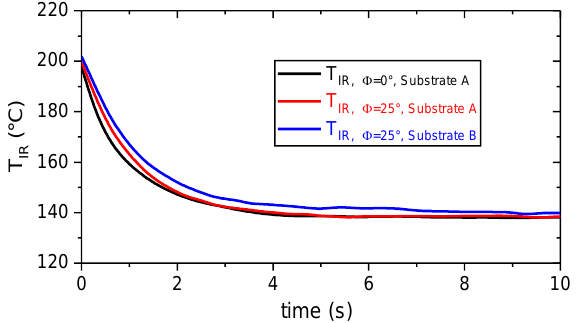
Figure 8. Polymer surface temperature, T IR, as a function of time during the extrusion of 0.6 mm high traces on T s = 150 °C hot aluminum substrates for different viewing angles, Φ , and positions on the hot plate. The temperature was determined by thermography based on an emissivity of 0.78 and the set-up presented in Figure 6.